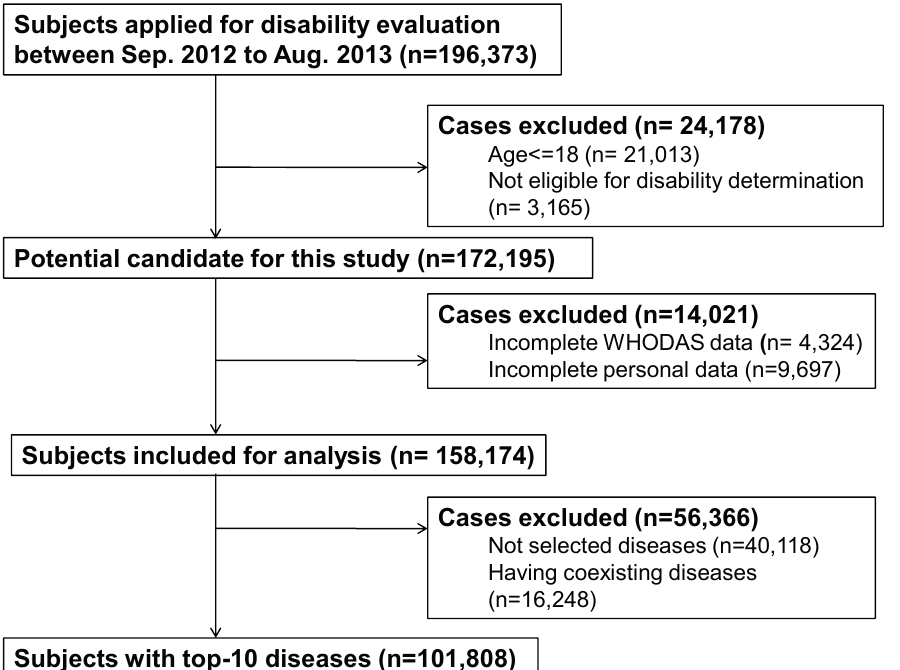
Figure 1. Case selection flowchart.